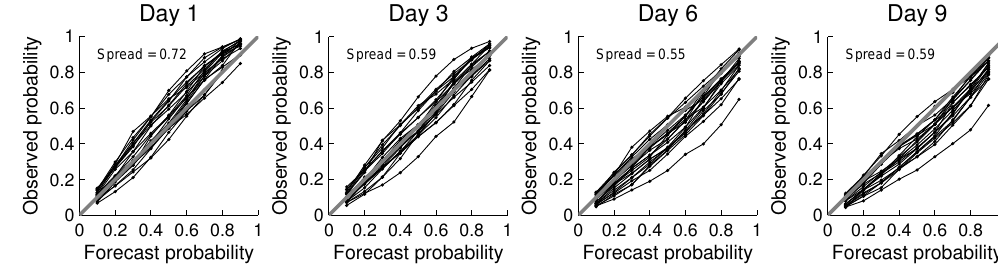
0 0.2 0.4 0.6 0.8 Figure 9. Reliability of the EnKF multimodel ensemble with MEPS forcing (system